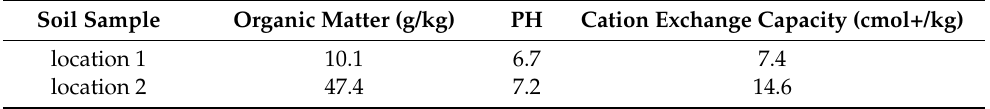
Table 1. Properties of soil